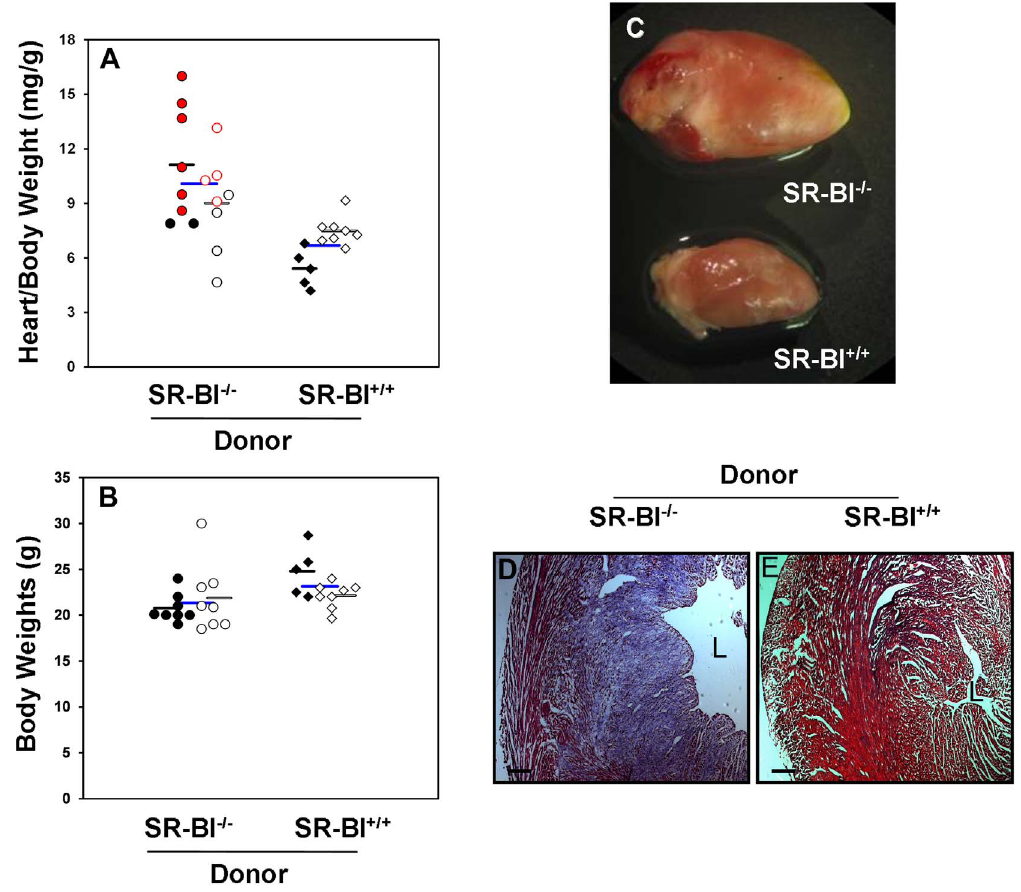
Figure 2. Restoration of SR-BI expression in BM derived cells attenuates diet induced increases in heart size and cardiac fibrosis in SR-BI-null/apoE-hypomorphic mice. A. Ratios of heart weight to body weight (HW:BW) are plotted for SR-BI 2 / 2 R SR-BI 2 / 2 mice (circles) and SR- BI + / + R SR-BI 2 / 2 mice (diamonds) fed the HFCC diet for 4 weeks. Red symbols identify those SR-BI 2 / 2 R SR-BI 2 / 2 mice which appeared to be in poor health or were moribund at collection. Closed symbols denote males and open symbols denote females. Horizontal bars indicate the mean heart/ body weight ratios (black bars = males, open bars = females, blue bars = pooled males and females). Data passed the Shapiro-Wilk test for normality and was analyzed by the Student’s T test; P , 0.0006 for SR-BI 2 / 2 R SR-BI 2 / 2 vs SR-BI + / + R SR-BI 2 / 2 mice. B. Body weights from the same mice as in A are plotted for male (closed symbols) and female (open symbols) SR-BI 2 / 2 R SR-BI 2 / 2 (circles) and SR-BI + / + R SR-BI 2 / 2 (diamonds). Bars denote average body weights: black bars = males, open bars = females; blue bars = pooled male + female mice. Differences in body weights between males (P=0.006) and when males and females were pooled (P=0.03) were significant, but females were not, by Student’s T test. C. Appearance of hearts from SR-BI 2 / 2 R SR-BI 2 / 2 and SR-BI + / + R SR-BI 2 / 2 mice after 4 weeks of HFCC diet feeding. D–E. Trichrome staining of cross sections of hearts from SR-BI 2 / 2 R SR-BI 2 / 2 (D) and SR-BI + / + R SR-BI 2 / 2 mice (E) after 4 weeks of HFCC diet feeding. Healthy myocardium appears red while collagen-rich fibrotic areas appear blue. L indicates the lumen of the left ventricle. Representative images are shown in C–E. Scale bars = 300 m m.